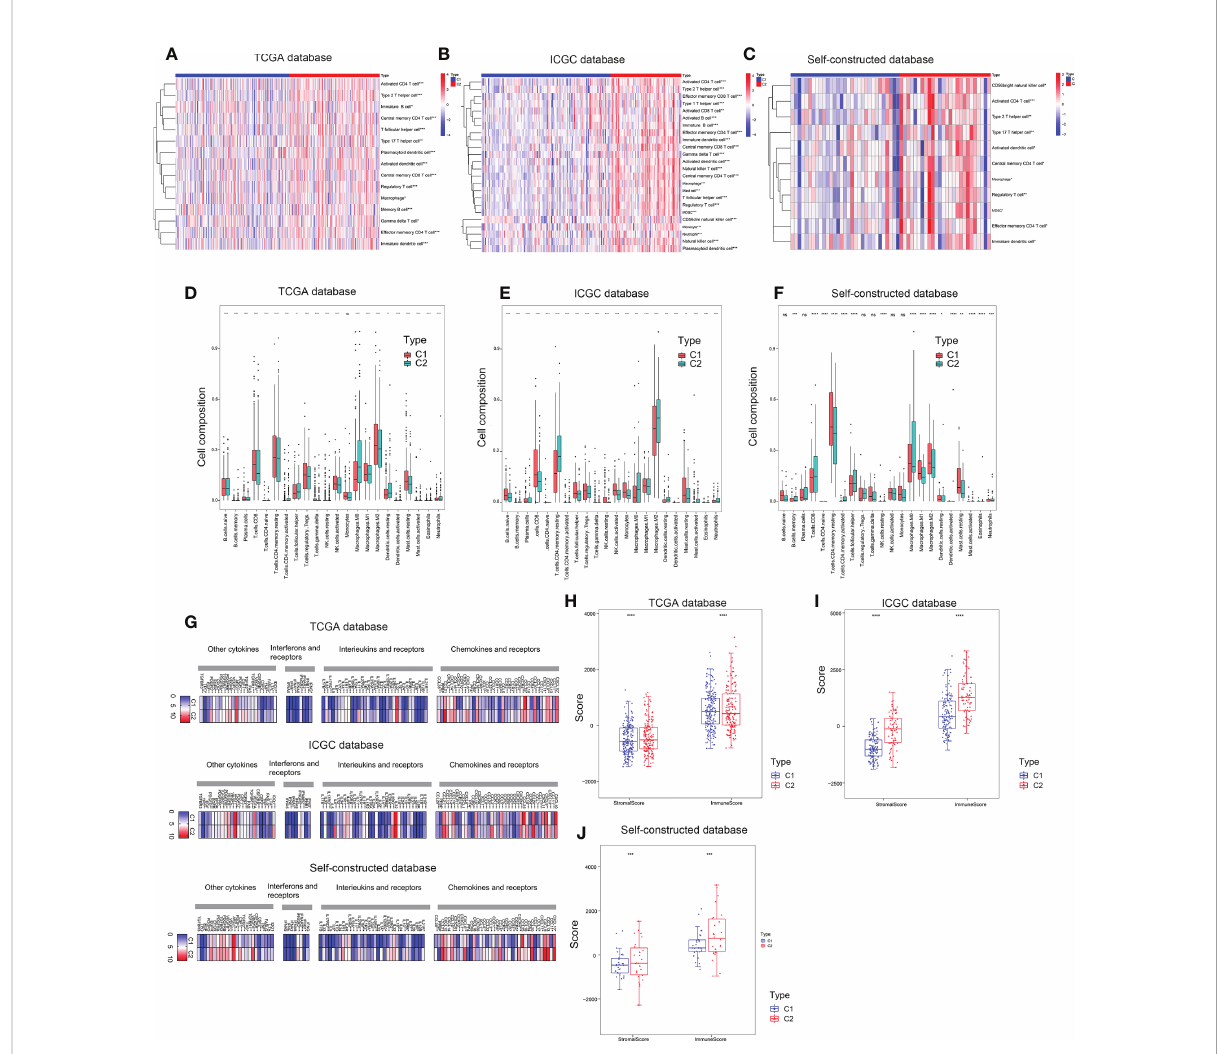
FIGURE 5 Immune microenvironment assessment of two subtypes. (A – C) ssGSEA enrichment analysis based on TCGA, ICGC and self-constructed database. (D – F) CIBERSORT analysis based on TCGA, ICGC and self-constructed database. (G) The expression pro fi le of key molecules involved in intercellular communication pathways, including cytokines, chemokines and receptors, interferons and receptors, interleukins and receptors based on TCGA, ICGC and Self-constructed database. (H – J) ESTIMATE analysis based on TCGA, ICGC and self-constructed database. *P<0.05, **P<0.01, ***P<0.001,